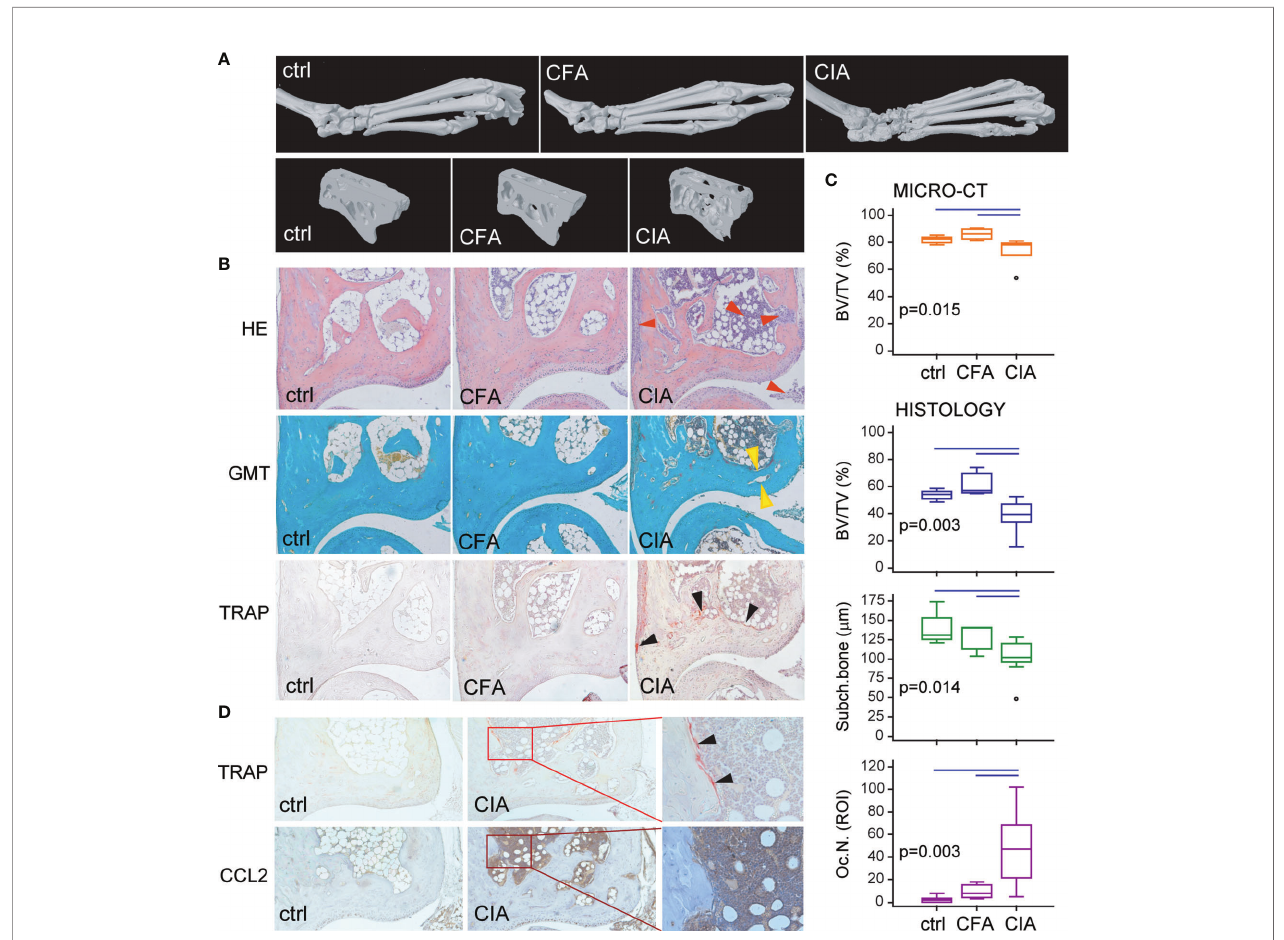
FIGURE 5 | Arthritis-induced bone destruction evaluated by micro-computerized tomography ( m CT) and histopathology of control (ctrl), Complete Freund ’ s Adjuvant treated control (CFA) and arthritic B6 mice (CIA). (A) Representative three-dimensional reconstructions of hind paws and fragments of talus scanned by m CT. (B) Representative images of tibiotalar joint histology sections in sagittal plane stained with hematoxylin and eosin (HE), Goldner-Masson trichrome (GMT), and histochemically stained for tartrate-resistant acid phosphatase (TRAP) (magni fi cation 100×); red arrows — areas of in fi ltration and pannus invasion; yellow arrows — subchondral bone plate; black arrows — areas with TRAP + osteoclasts. (C) Talar bone volume analysis by m CT [total bone volume/total tissue volume, BV/TV (%)], histomorphometric analysis of distal tibia [subchondral and trabecular bone/total tissue volume, BV/TV (%)], subchondral plate thickness [subch. bone interlabel distance (µm)], and number of TRAP + osteoclasts (Oc.N.) at endosteal surfaces of distal tibia (region of interest, ROI) of ctrl, CFA, and CIA mice. The experiments were repeated three times and data from a representative experiment are shown ( n = 6 – 10 mice per group). Values are presented as medians (middle horizontal lines), boxes represent the interquartile range (IQR), whiskers represent 1.5 times the IQR, and outliers are represented by circles. Statistically signi fi cant difference was determined at p < 0.05, Kruskal – Wallis test ( p -value marked on the graph) with Conover post-hoc test for group-to-group comparisons; line denotes signi fi cant difference between groups. (D) Representative images of tibiotalar joint sections histochemically stained for TRAP activity and immunohistochemically stained for CCL2 expression in ctrl and CIA mice (magni fi cation 100×); selected area (in rectangle, magni fi cation 200×); black arrows — areas with TRAP +